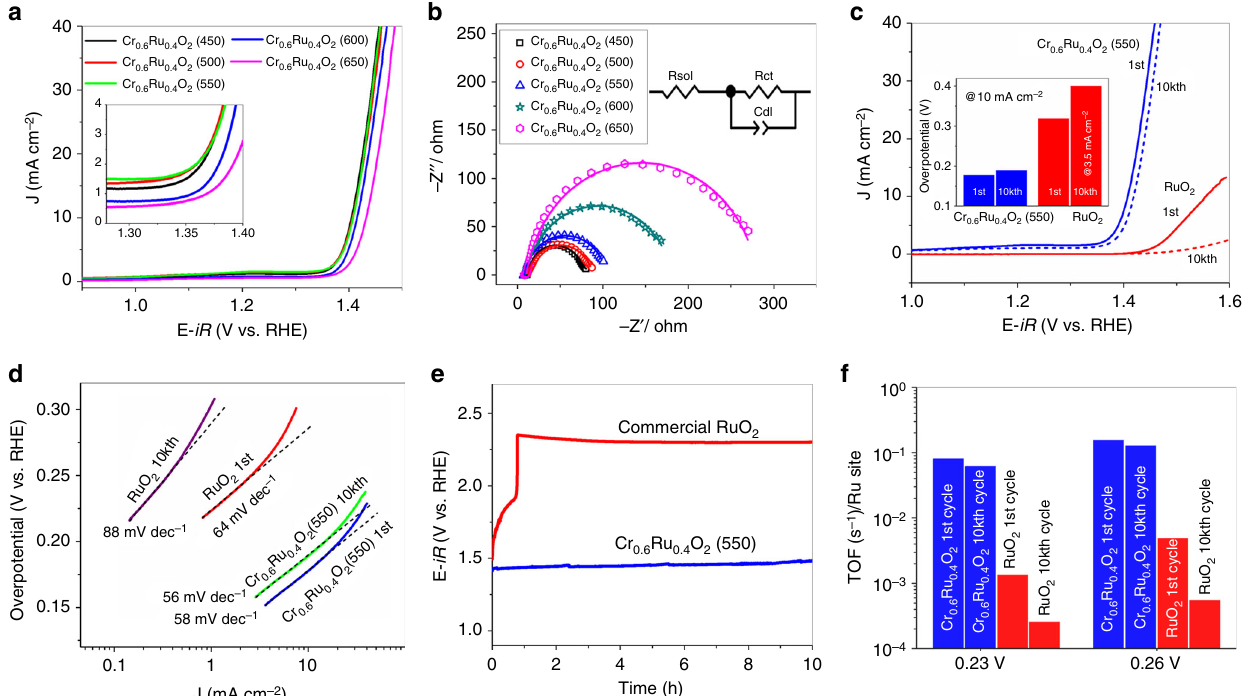
Fig. 4 OER activity of Cr 0.6 Ru 0.4 O 2 annealed at different temperature. a Electrocatalytic OER activities of Cr 0.6 Ru 0.4 O 2 (450 – 650) nanoparticiles; b Nyquist plots at 1.395 V. Solid curves are the fi tting results by using the equivalent circuit shown in the inset; c LSVs of Cr 0.6 Ru 0.4 O 2 (550) and commerical RuO 2 for the fi rst and 10,000th cycle. Inset shows the comprarsion of overpotentials for Cr 0.6 Ru 0.4 O 2 (550) and RuO 2 at the current density of 10 mA cm − 2 at the fi rst and 10,000th cycle. For RuO 2 after 10,000 cycles, the overpotential is corresponded to 3.5 mA cm − 2 which is the maxium current density of its LSV curve; d Tafel plots of Cr 0.6 Ru 0.4 O 2 (550) and RuO 2 at fi rst and 10,000th cycle; e Chronopotentiometry performance under constant current